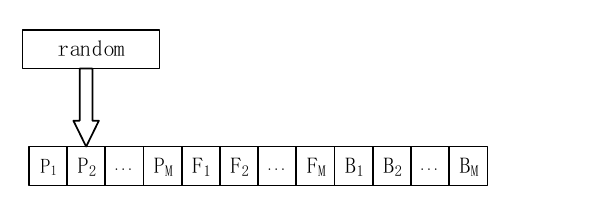
Figure 4. Mutation operation.